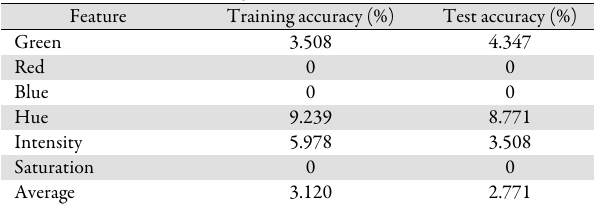
96 Table 2. Accuracy values using one colour feature